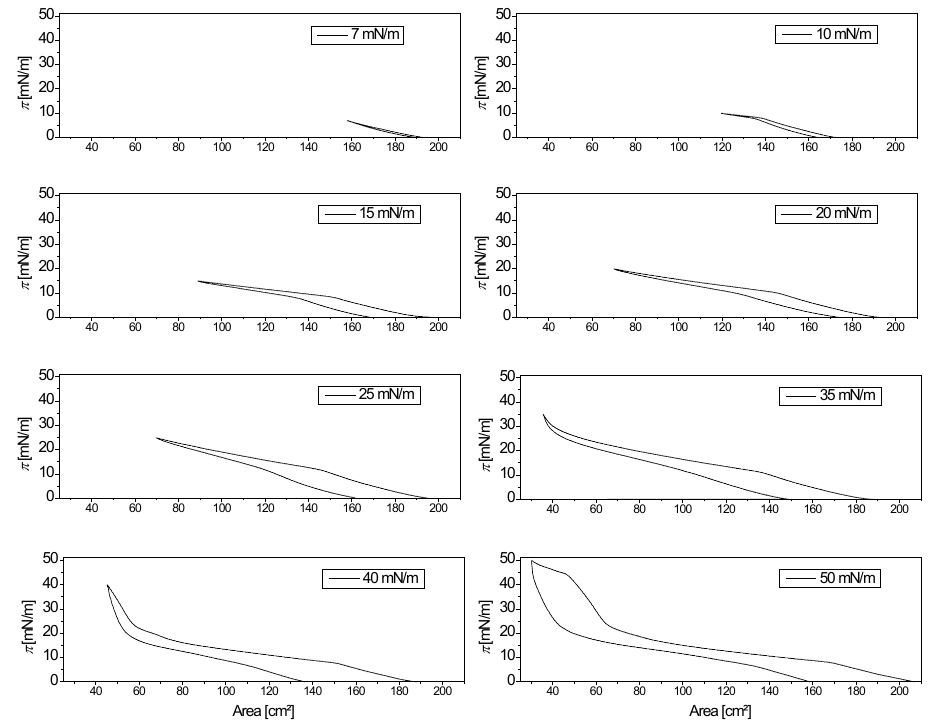
Figure 4. Surface pressure ( π(A) ) hysteresis (compression-expansion samples) at 21 °C. The values in each panel indicate the surface pressure value where the barrier movement was reversed (maximum compression). The upper curves correspond to compression and lower ones to expansion cycles.